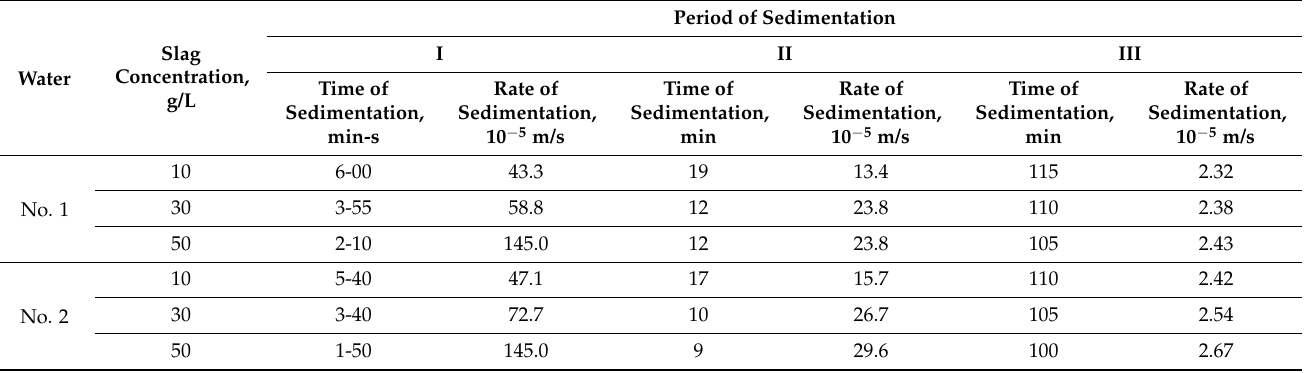
Table 17. Time and rate of sedimentation of slag particles in water dispersed media of different hardness without ultrasonic